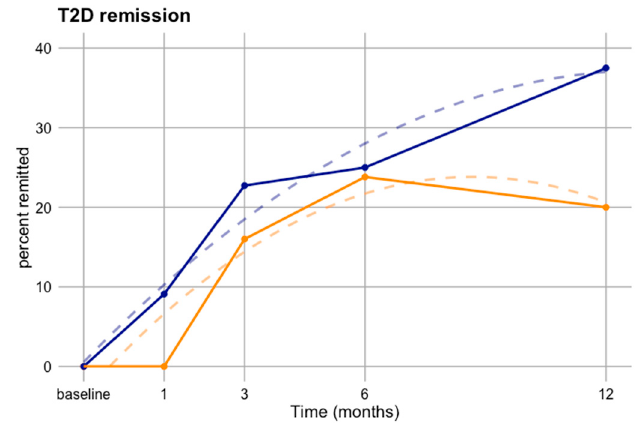
Figure 5. T2D remission percentage (number remitted / number with type 2 diabetes at baseline) in men and women from baseline to final follow-up exam. Dashed lines represent quadratic fits. T2D–type 2 diabetes.